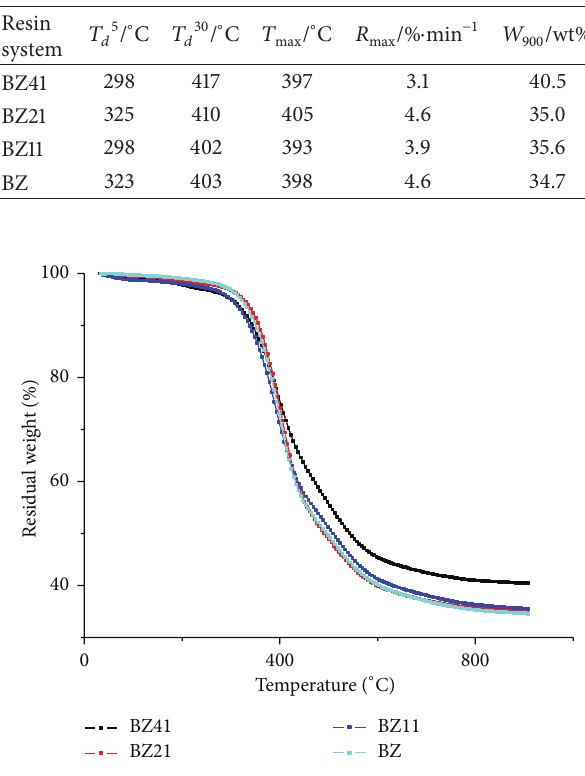
Figure 9: TGA curves of BOZ-M/F-51 hybrid networks.